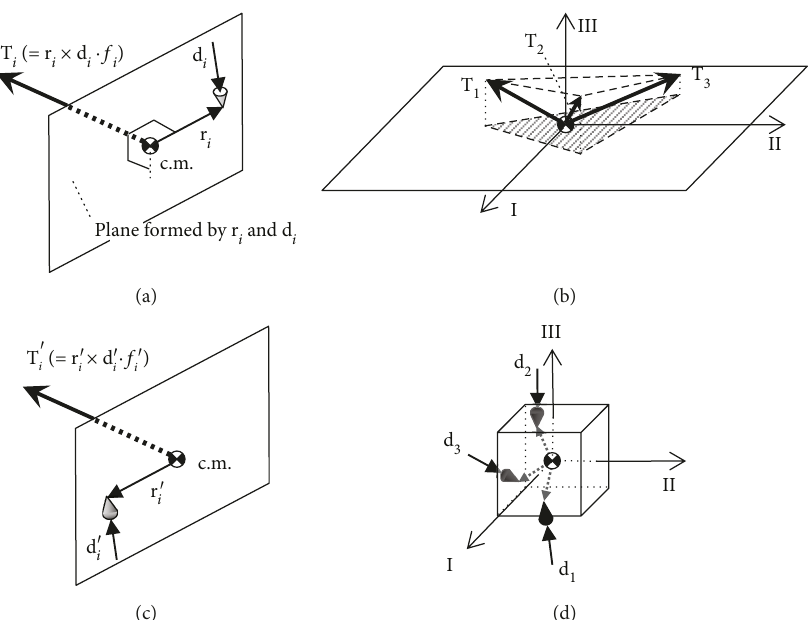
Figure 1: Three-thruster con fi guration for attitude and position control. (a) Direction of the torque vector. (b) Geometry formed with the three torque vector. (c) Another thruster placement. (d) Three-thruster con fi